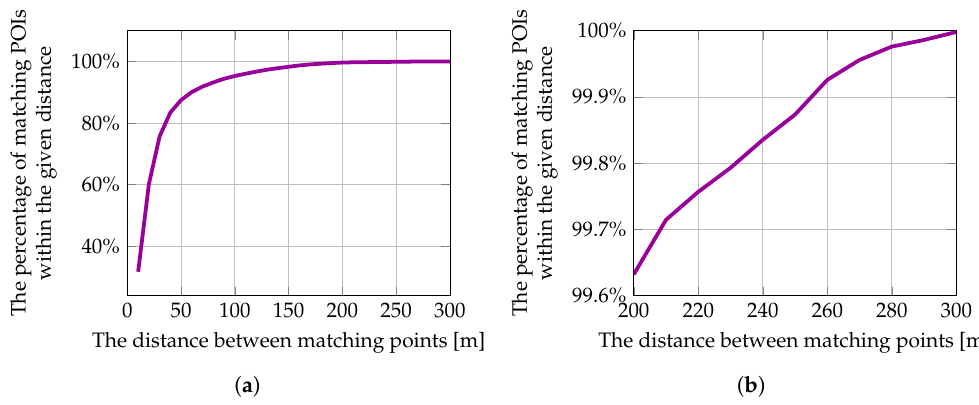
Figure 9. The percentage of matching POIs within the range of 0–300 m ( a ); and for the sub-range of 200–300 m ( b